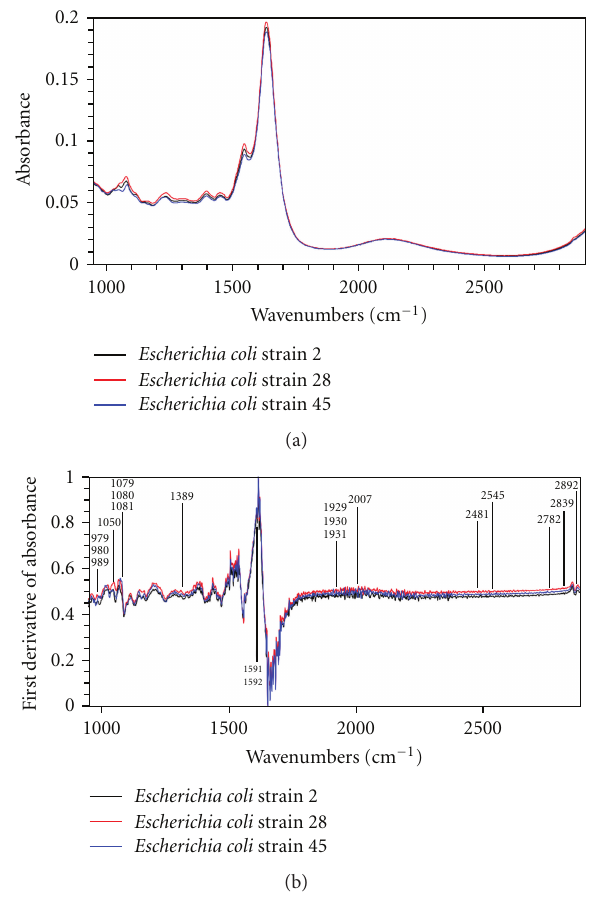
F1:(a)UnprocessedbacterialATRFT-IRspectra,(b)bacterial ATRFT-IRspectraaerpreprocessing.Verticallinesmarkthebands used for